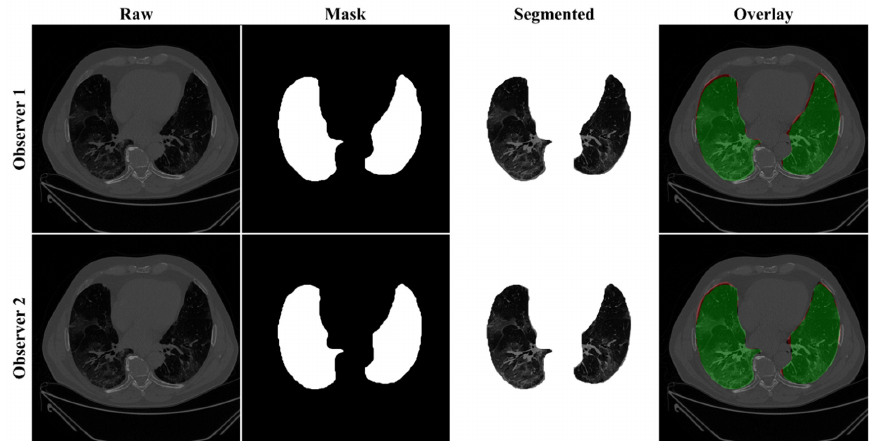
Figure 7. Results from PSP Net while using Observers 1 and 2. Columns are the raw, binary mask output, segmented lung region, and overlay of the estimated lung region vs. ground truth region.